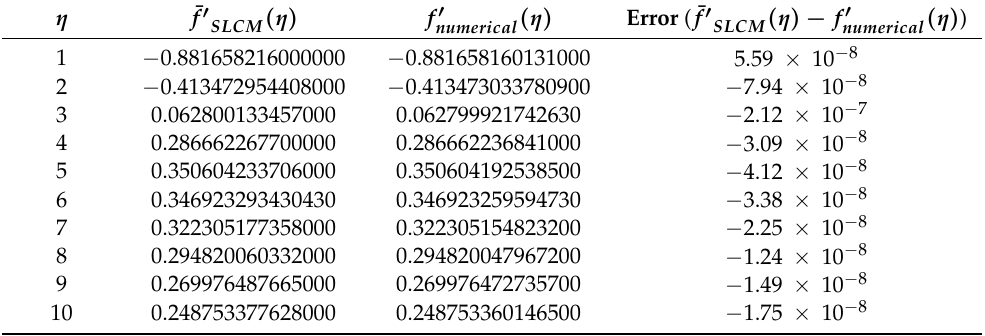
Table 6. Estimations of error for f (cid:48) ( η ) for λ = − 1 (injection) by setting S = − 1.0, M = 0.0, φ s 1 = 0.0, φ s 2 = 0.0, Ec = 0.0.